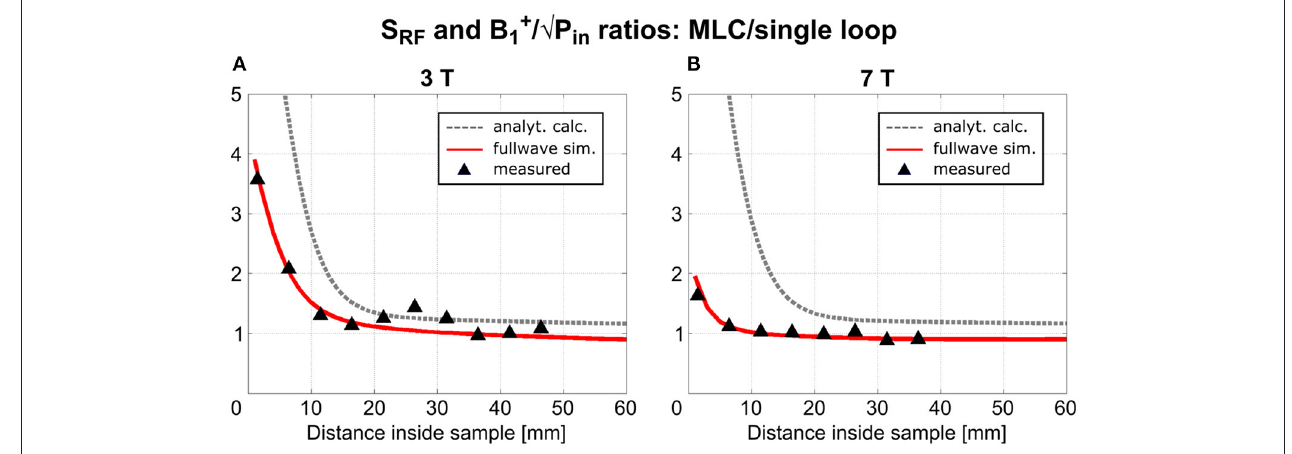
FIGURE 5 | Ratios of RF sensitivity and transmit efficiency between MLCs and SLCs along the central coil axis— (A) for 3T coils and (B) for 7 T coils.